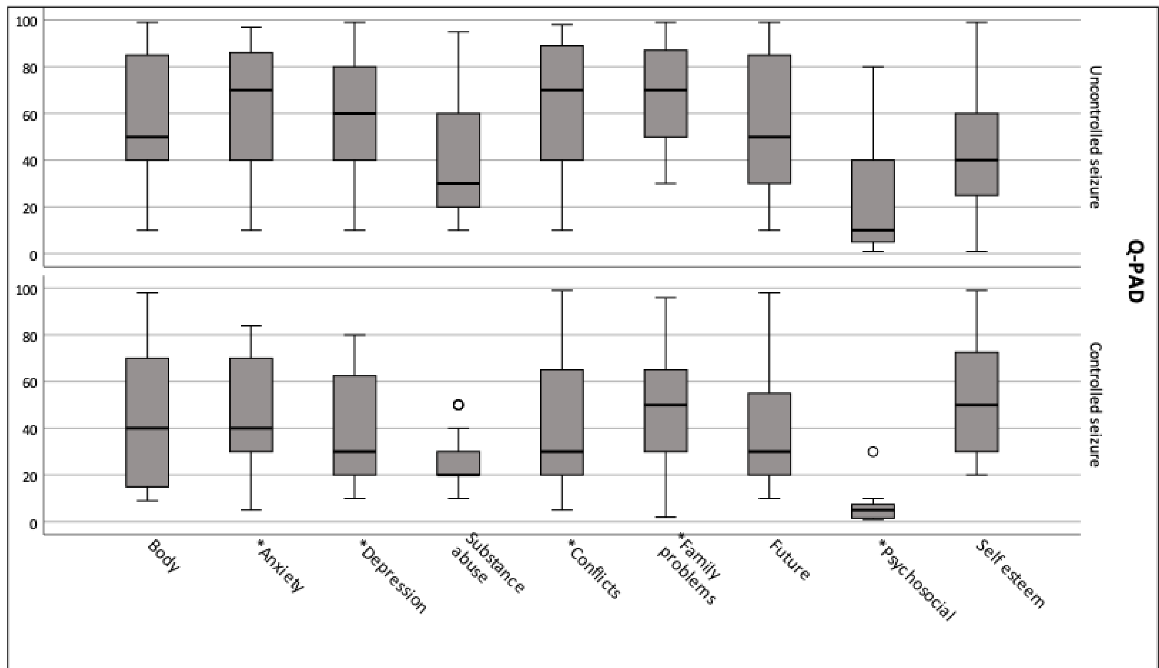
Figure 2. Q-PAD scores for adolescents with uncontrolled seizures vs. controlled seizures. Figure legend: Q-PAD scores of adolescents with uncontrolled seizures compared to patients with controlled seizures (minimum score, first (lower) quartile, median, third (upper) quartile, and maximum score). * Significant scores. ◦ Outlier value. Abbreviations: Q-PAD: Questionnaire for the Assessment of Psychopathology in